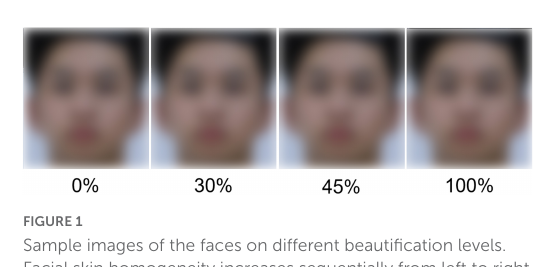
FIGURE1 Sample images of the faces on different beautification levels. Facial skin homogeneity increases sequentially from left to right. The leftmost image is the original face with 0% beautification, and the remaining three images are its variant versions with 30, 45, and 100% level